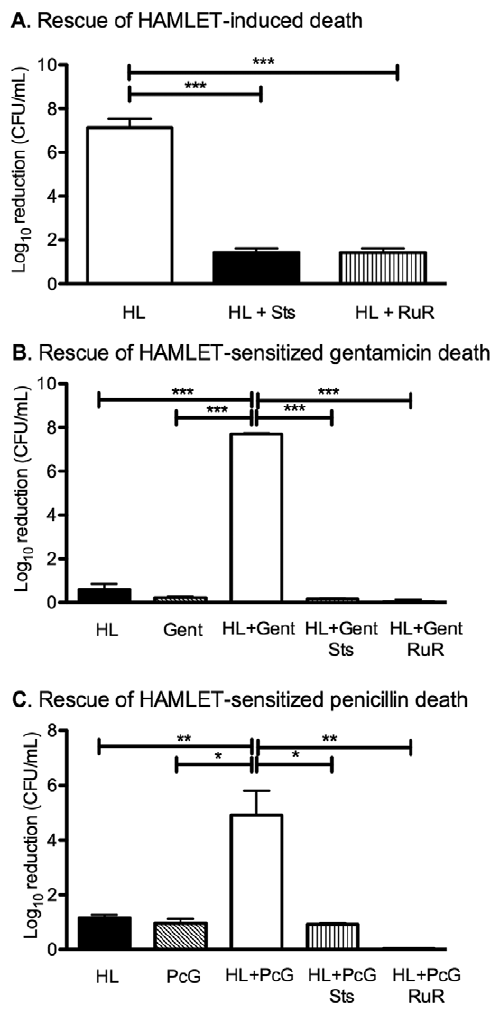
Figure 6. Effect of calcium and kinase inhibitors on HAMLET- induced sensitization of pneumococci to gentamicin. (A) S. pneumoniae D39 were treated with a lethal concentration of HAMLET (12X MIC) in the absence of inhibitor (HL) or presence of 20 m M staurosporine (HL + Sts), or 30 m M ruthenium red (HL + RuR) for 1 hour at 37 u C. The treated bacteria were diluted and plated on blood agar plates and viable CFU/ml were determined after overnight growth. (B and C) S. pneumoniae D39 were treated with 50 m g/mL HAMLET (HL), 50 m g/mL gentamicin (Gent), 20 m g/mL penicillin G (PcG), or a combination of gentamicin and HAMLET or penicillin G and HAMLET in the absence (HL + Gent, HL + PcG) or presence of 20 m M staurosporine (Sts), or 30 m M ruthenium red (RuR) for 1 hour at 37 u C. The treated bacteria were diluted and plated on blood agar plates and viable CFU/ml were determined after overnight growth. The graph depicts the log 10 death induced by each treatment and showed that staurosporine and ruthenium red significantly reduced HAMLET- induced death (A) and also significantly blocked HAMLET’s ability to sensitize pneumococci to gentamicin (B) and penicillin G (C). The results are based on three individual experiments with duplicate samples. Statistics was performed using the unpaired Student t-test. Significance was indicated as follows: ***= P , 0.001.